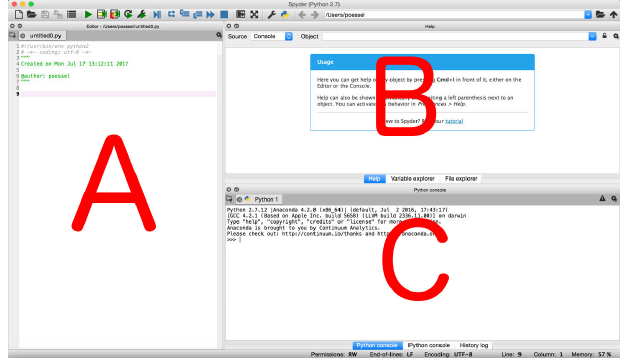
Fig. 79.— Basic Spyder